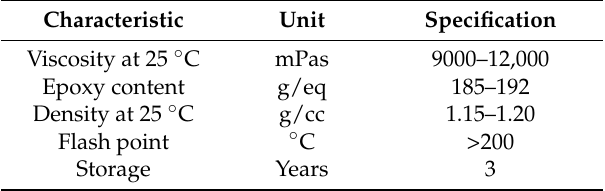
Table 2. Properties of HINPOXY C resin.